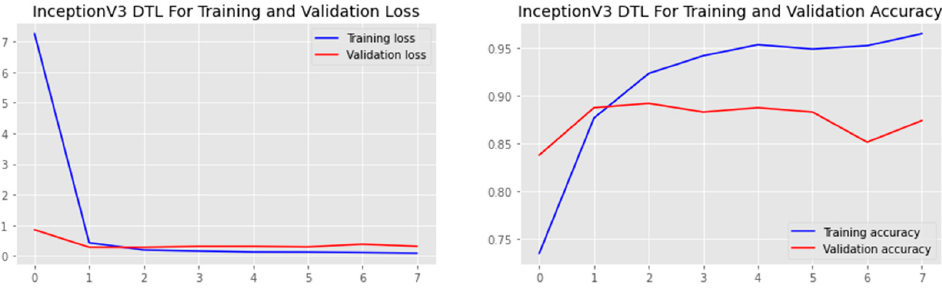
Figure 6. Accuracy and loss graph of the InceptionV3 model .